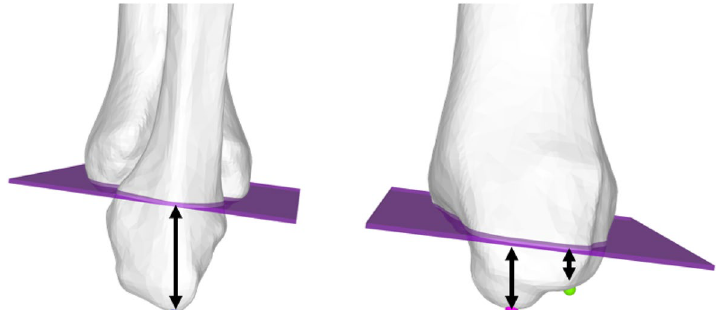
Fig. 3 Fibular tip and medial malleolar anterior and posterior colliculus distance to ankle joint line. Left: lateral view depicts fibular tip (blue sphere). Right: medial view depicts anterior medial colliculus (pink sphere) and posterior medial colliculus (green sphere). Shortest distance of anatomical landmarks to ankle joint line is measured (mm, black arrows)